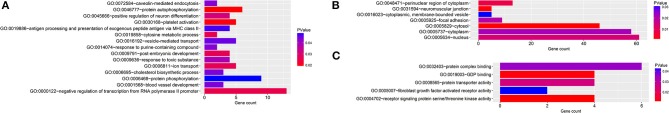
GO analysis of hsa-miR-210 target genes. GO enrichment of target genes in biological process ontology (A), cellular component ontology (B) and molecular function ontology (C).